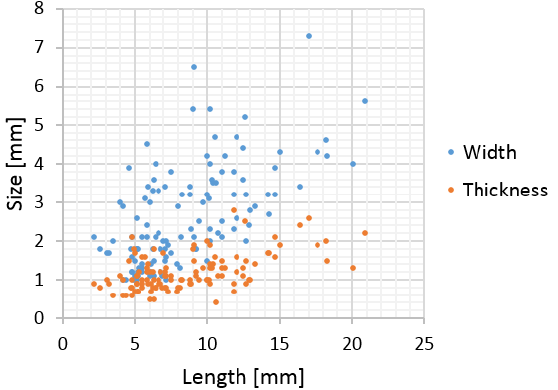
Figure 3. Hemp shives granulation.